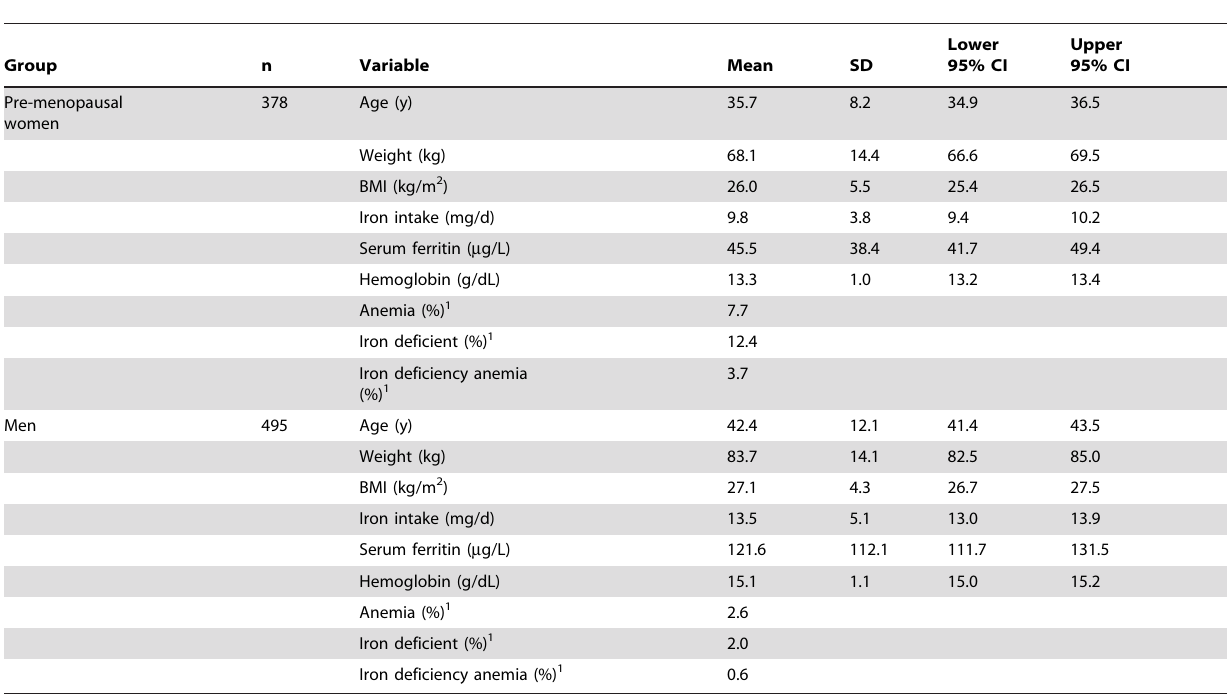
Table 1. Summary statistics for iron intake and status of the population sub-sample.